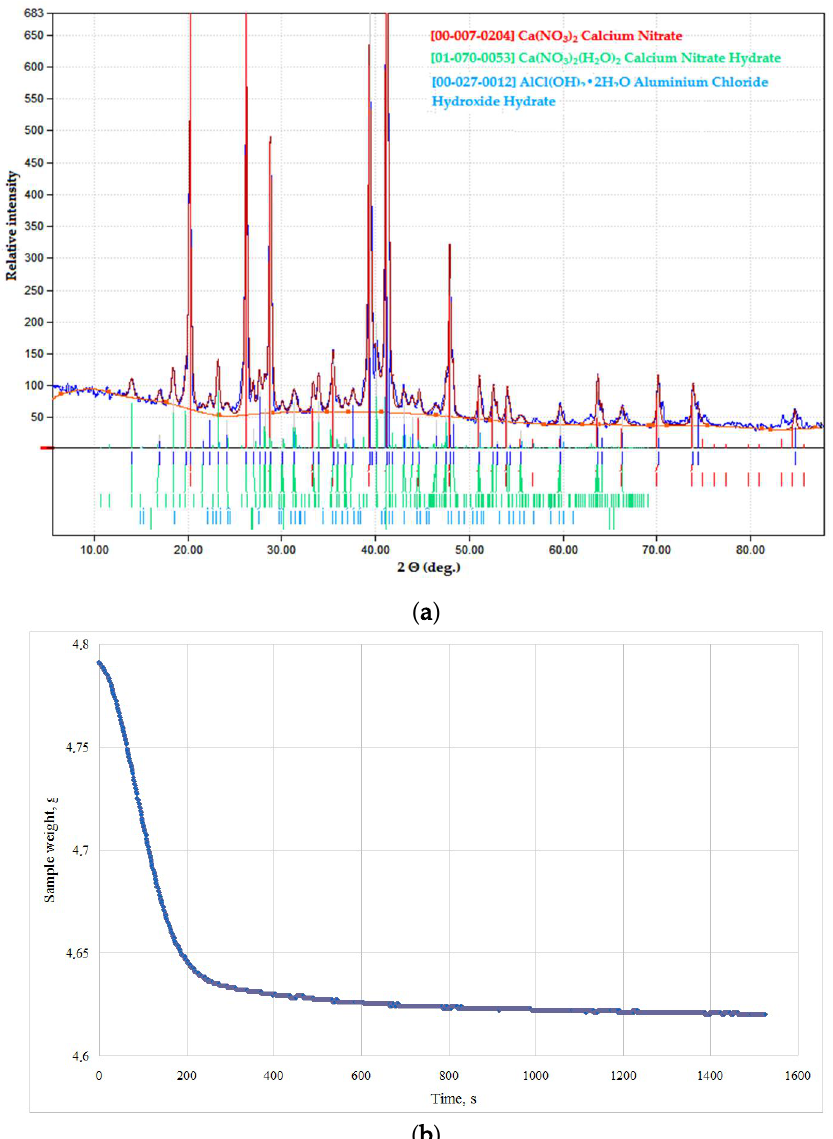
Figure 4. Products of a nitrate solution microwave (MW) drying in the CaO–Al 2 O 3 –Y 2 O 3 (CAY) system: ( a ) phase composition; ( b ) weight loss.